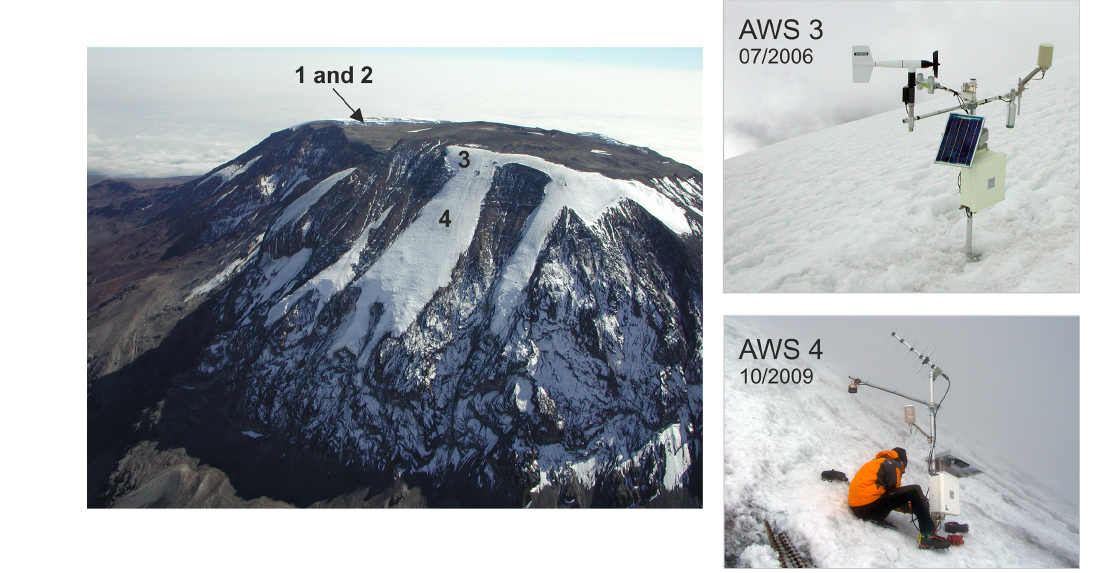
Figure 1. Aerial photo of Kilimanjaro’s central part Kibo in July 2005, indicating the locations of the automatic weather stations. The pictures on the right side show the data sources for this study in more detail (photos: Nicolas J. Cullen, Georg Kaser, Rainer